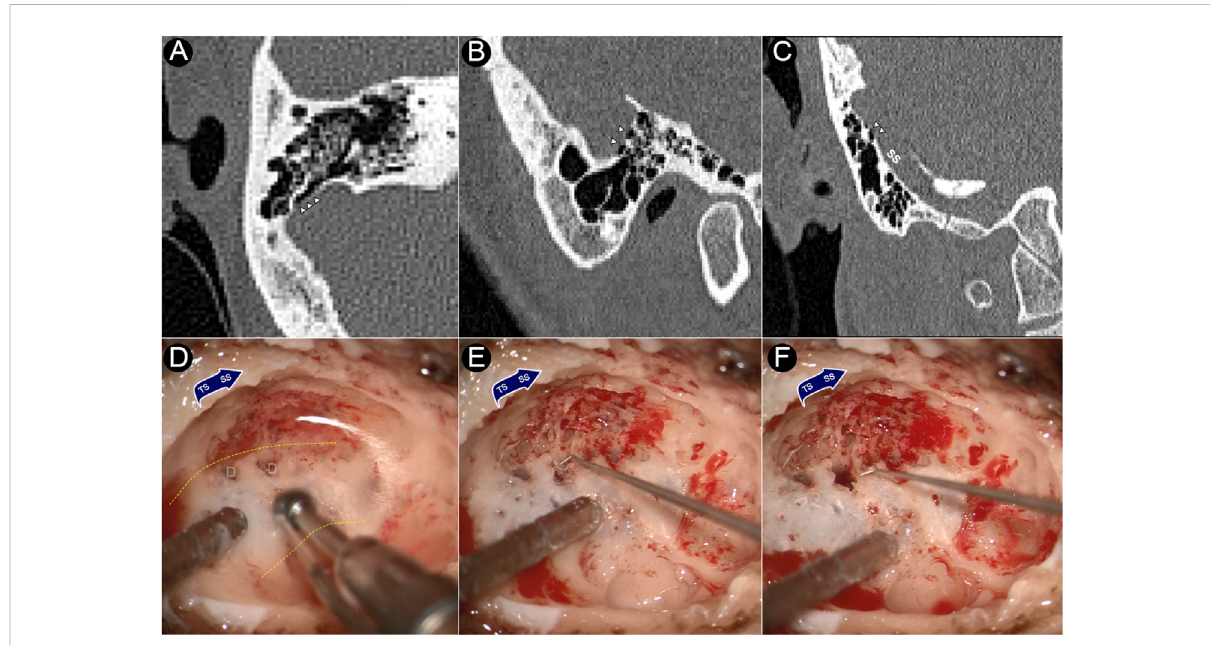
FIGURE 1 CT images and intraoperative photographs of the participant with sigmoid plate dehiscence. (A) Axial plane of dehiscence; (B) sagittal plane of dehiscence; (C) coronal plane of dehiscence. (D) Dehiscence exposed during skeletonization of sigmoid sinus. (E) Harvesting the dehiscent sigmoid plate. (F) After the removal of the dehiscent sigmoid plate. Triangles indicate the location of dehiscence. D represents dehiscence. Yellow dashed lines indicates the silhouette of the sigmoid